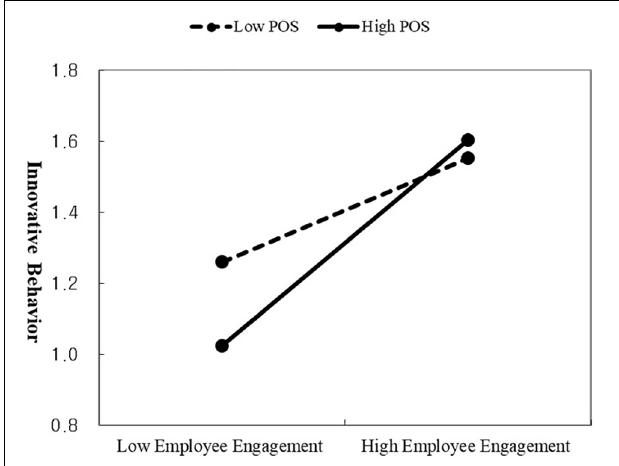
FIGURE 2 | Moderating effect of POS on the relationship between employee engagement and innovative behavior.